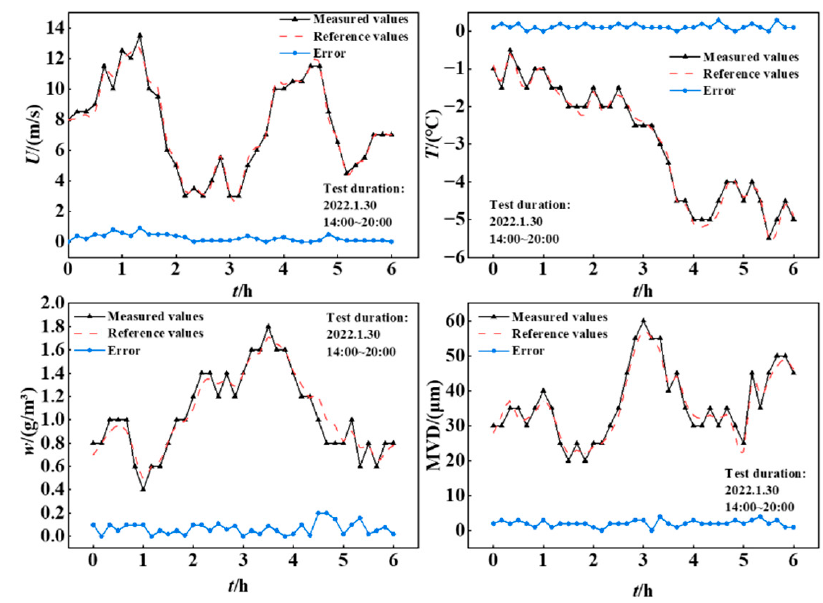
Figure 14. The comparison of measured with reference values.